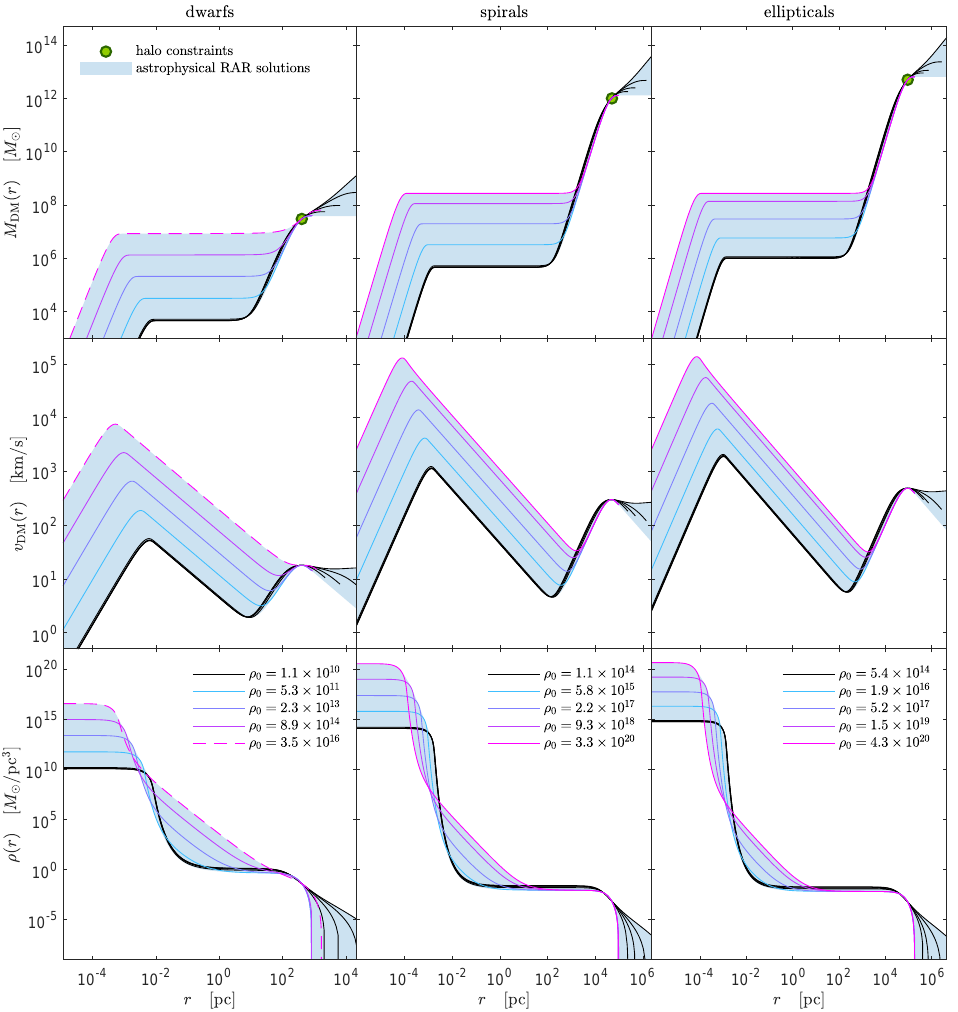
Figure 8. Astrophysical RAR solutions, for the relevant case of mc 2 = 48 keV, observationally fulfill given DM halo restrictions ( r h , M h ) for typical dwarf ( left ), spiral ( middle ), and elliptical galaxies ( right ). Shown are density profiles (bottom), rotation curves (middle), and DM mass distributions ( top ). The full window for each galaxy type is illustrated by a blue shaded region and enveloped approx. by 5 benchmark solutions inside. Each solution is labeled with the central density in units of M (cid:12) pc − 3 . The continuous magenta curves, occurring only for spiral and elliptical galaxies, indicate the critical solutions that develop compact, critical cores (before collapsing to a BH) of M crit c = 2.2 × 10 8 M (cid:12) . The dashed magenta curves for dwarfs are limited (instead) by the astrophysical necessity of a maximum in the halo rotation curve. The bounding black solutions correspond to the ones having the minimum core mass (or minimum ρ 0 ), which in turn imply larger cutoff parameters (implying ρ ∝ r − 2 when W 0 → ∞ . Reprinted from [33], Copyright (2019), with permission from